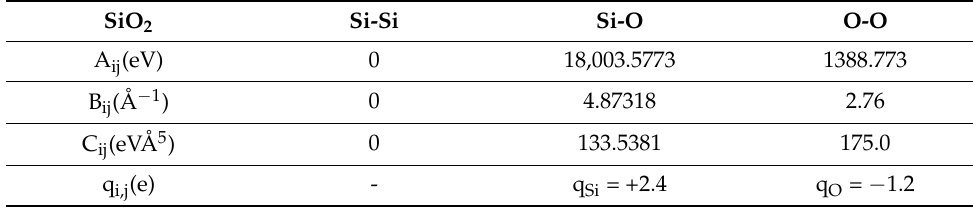
Table 1. Parameters of the bulk SiO 2 material